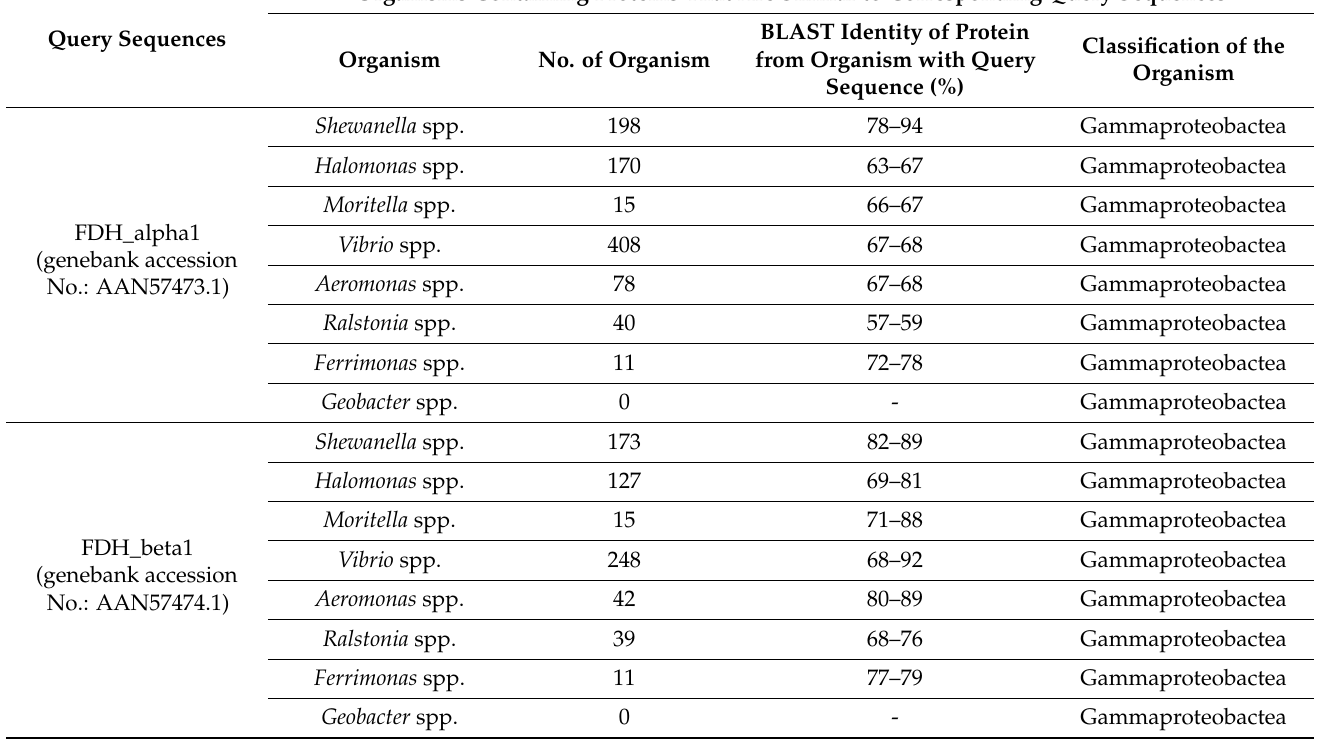
Table 2. BLASTing results of formate dehydrogenases and several electron-transporting proteins from Shewanella oneidensis MR1 against available sequences in nr protein